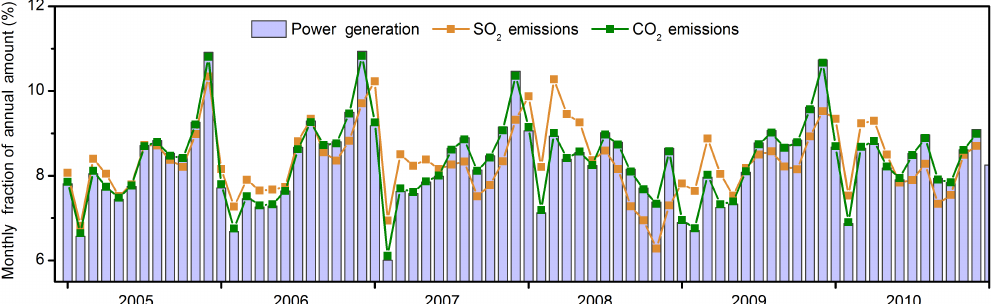
Figure 11. Monthly profiles of thermal power generation and coal-fired power-plant SO 2 and CO 2 emissions in China. The y axis values represent the fraction of monthly emissions of annual emissions.